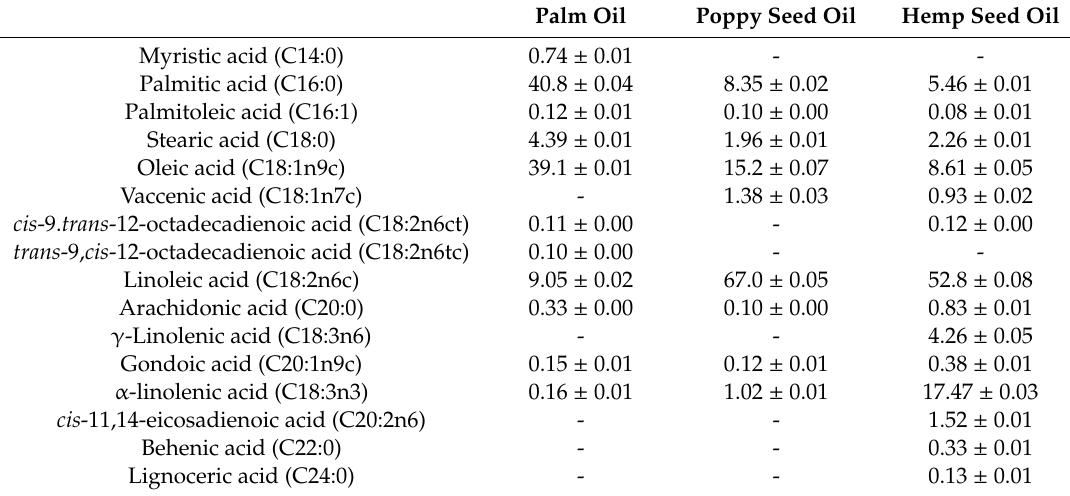
Table 4. Fatty acid profile